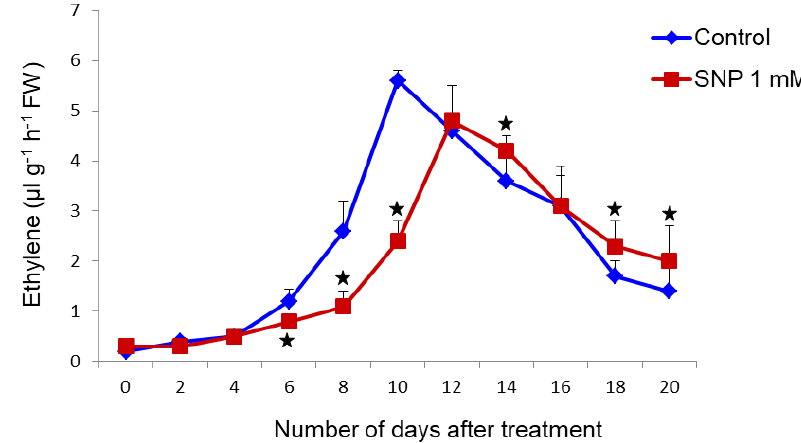
Figure 4. Changes in ethylene levels in treated banana fruits measured by gas chromatography. The values are means of three replicates. *Mean difference is significant at the p ≥ 0.05 level as analyzed by one-way analysis of variance followed by post hoc test least significance difference.